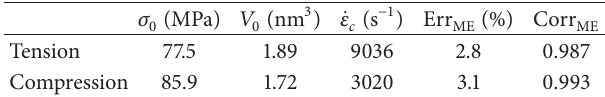
Table 4: Material constants, error, and correlation of the modified- Eyring